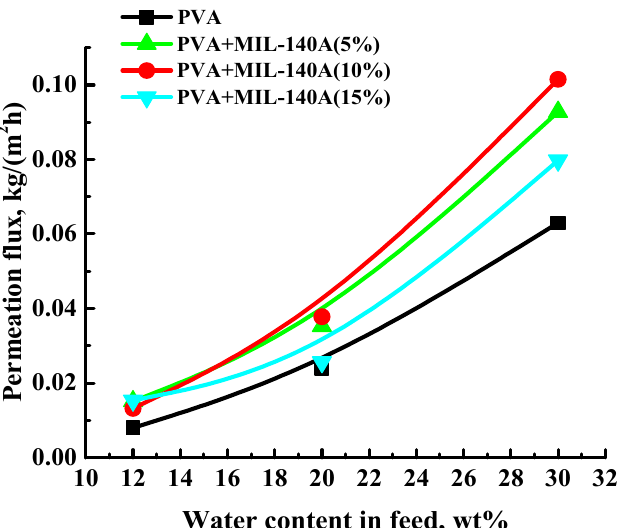
Figure 1. The dependence of the permeation flux on the water content in the feed for the uncross- linked PVA and PVA/MIL-140A membranes in pervaporation separation of water/isopropanol mixtures (12, 20, and 30 wt% water) at 22 °C. Water content in the permeate for all uncross-linked PVA and PVA/MIL-140A membranes was 99.9 wt%.